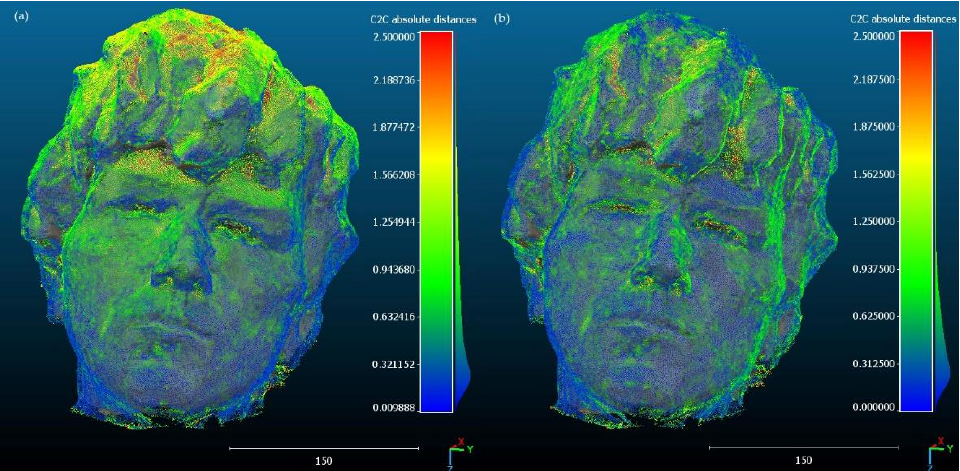
Figure 6. Deviations between the reference model and the model from Xiaomi Redmi Note 11S images: ( a ) with self-calibration, ( b ) with pre-calibration.